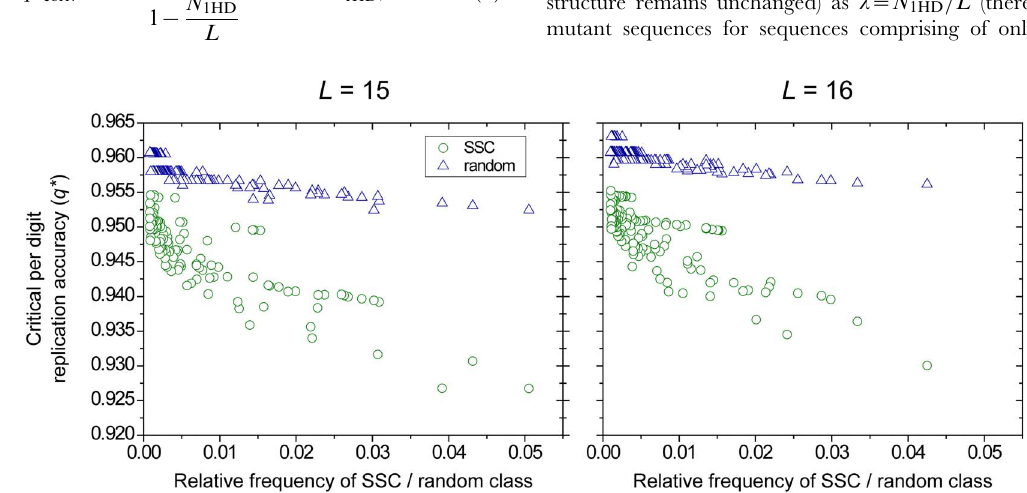
Figure 2. Error threshold for random sequences. The green circles represent SSCs based on secondary structures (as in Fig. 1), blue triangles represent the error threshold of classes of random sequences of the same size as the corresponding SSC. Results are for L ~ 15 (left) and L ~ 16 (right).